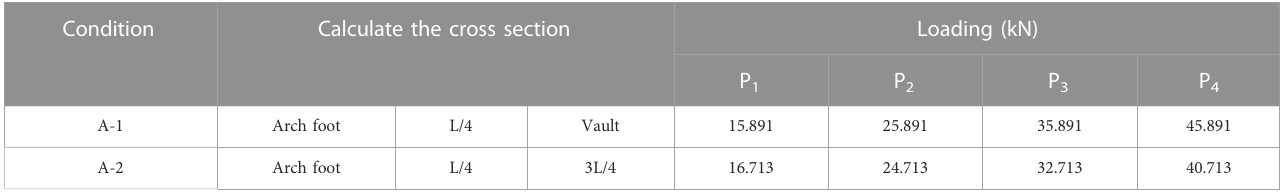
TABLE 6 Selection of calculation parameters.